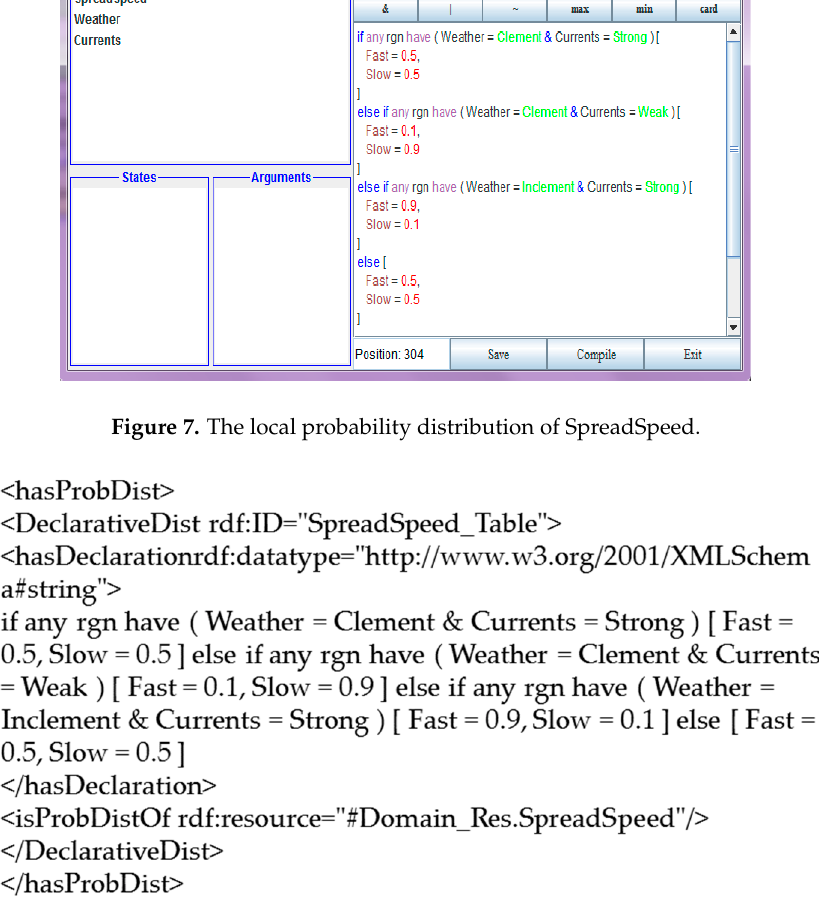
Figure 8. Ontology annotation of SpreadSpeed local probability distribution.